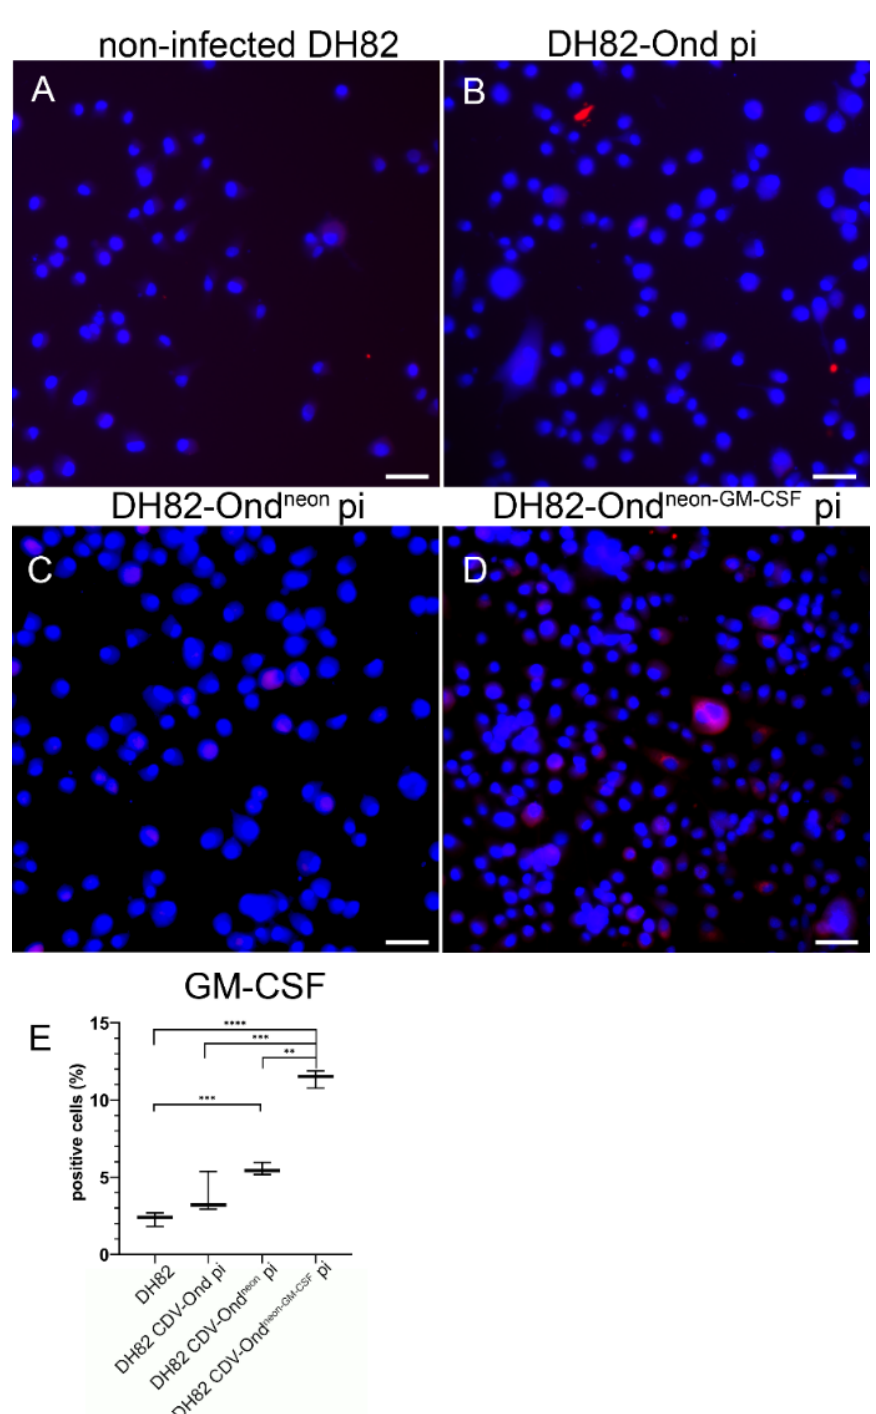
Figure 5. Immunofluorescence using an anti-GM-CSF antibody in non-infected controls and DH82 cells persistently infected with CDV-Ond, CDV-Ond neon and CDV-Ond neon-GM-CSF , respectively. Im- munostaining of non-infected DH82 cells ( A ) and DH82 cells persistently infected with CDV-Ond ( B ), CDV-Ond neon ( C ), and CDV-Ond neon-GM-CSF ( D ) displayed a significantly higher percentage of positive cells (red) in DH82 cells infected with CDV-Ond neon-GM-CSF compared to all other groups. Nuclei were counterstained with bisbenzimide (blue). Bars = 20 µm. ( E ) Graphical presentation of the percentage of GM-CSF-expressing cells in all analyzed cultures as determined by immunofluo- rescence. Box plots represent minimum, median and maximum. Significant differences (Mann– Whitney-U test) are labeled by asterisks: ** = p < 0.01; *** = p < 0.001; **** = p < 0.0001.